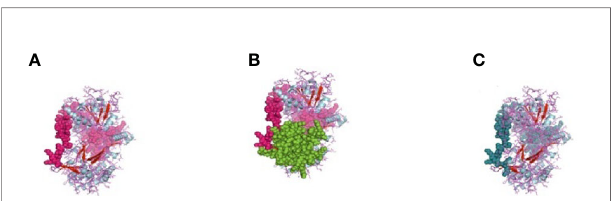
FIGURE 3 | (A) MPH1 ERCC4-related helicase (replication, recombination and repair) of sheep. (B) CARD: a protein – protein interaction domain of sheep. (C) PRK13766, Hef nuclease; Provisional.